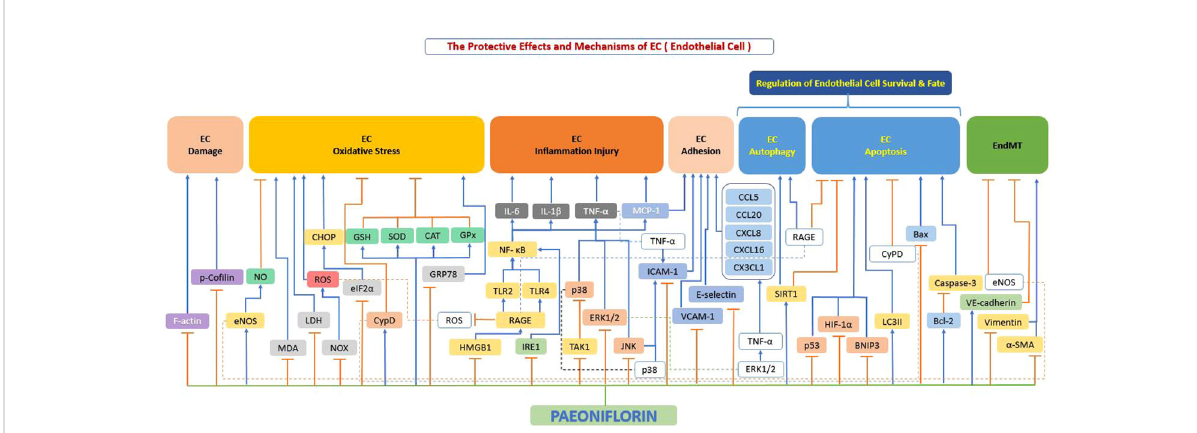
FIGURE 5 The protective effects and mechanisms of paeoni fl orin on endothelial cells. Paeoni fl orin can exert protective effects on endothelial cells and thus on atherosclerosis through various mechanisms, which mainly include: inhibition of cell damage, inhibition of oxidative stress, prevention of excessive production of in fl ammatory factors, improvement of cell adhesion function, regulation of cell autophagy and apoptosis. Bax, Bcl-2- associated X protein; Bcl-2, B-cell lymphoma-2; CAT, catalase; CCL20, c-c chemokine ligand 20; CCL5, c-c chemokine ligand 5; CHOP, C/EBP homologous protein; CX3CL1, c-x-3-c chemokine ligand 1; CXCL16, c-x-c motif chemokine ligand 16; CXCL8, c-x-c motif chemokine ligand 8; CypD, cyclophilin D; eIF2 a , eukaryotic initiation factor 2 a ; eNOS, endothelial nitric oxide synthase; ERK1/2, extracellular signal-regulated kinase 1/2; F-actin, fi lamentous actin; GPx, glutathione peroxidase; GRP78, glucose-Regulated Protein 78; GSH, glutathione; HIF-1 a , hypoxia-inducible factor-1 a ; HMGB1, high mobility group box 1; ICAM1, intercellular adhesion molecule 1; IL-1 b , interleukin 1 b ; IL-6, interleukin 6; JNK, c-Jun N- terminal kinase; LC3II, light chain 3 II; LDH, lactate dehydrogenase; MCP-1, monocyte chemoattractant protein-1; MDA, malondialdehyde; NF- k B, the nuclear factor-kB; NO, nitrous oxide; NOX, NADPH-oxidase; p38, p38 mitogen-activated protein kinase (MAPK); p53, tumor protein p53 (also known as TP53); p-Co fi lin, phosphorylation of co fi lin; RAGE, receptor for advanced glycation end products; ROS, reactive oxygen species; Sirt1, sirtuin 1; SOD, superoxide dismutase; TAK1, transforming growth factor beta-activated kinase1; TLR2, toll-like receptor 2; TLR4, toll-like receptor 4; TNF- a , tumor necrosis factor a ; VCAM1, vascular cell adhesion molecule 1; VE-cadherin, vascular endothelial (VE)-cadherin; a -SMA, alpha-smooth muscle